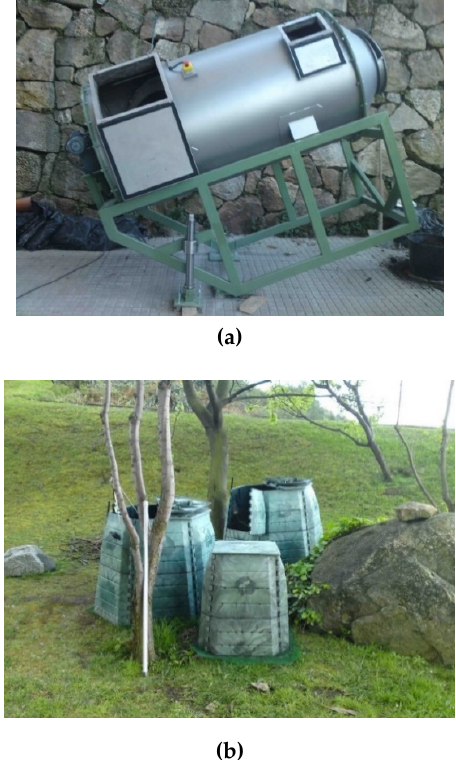
Figure 1. Composting system at the School of Architecture: ( a ) First step Dynamic composter, Plana ® design, ( b ) Maturation static composters (2 Container KOMP 1050 units and 1 Container KOMP 340 unit).